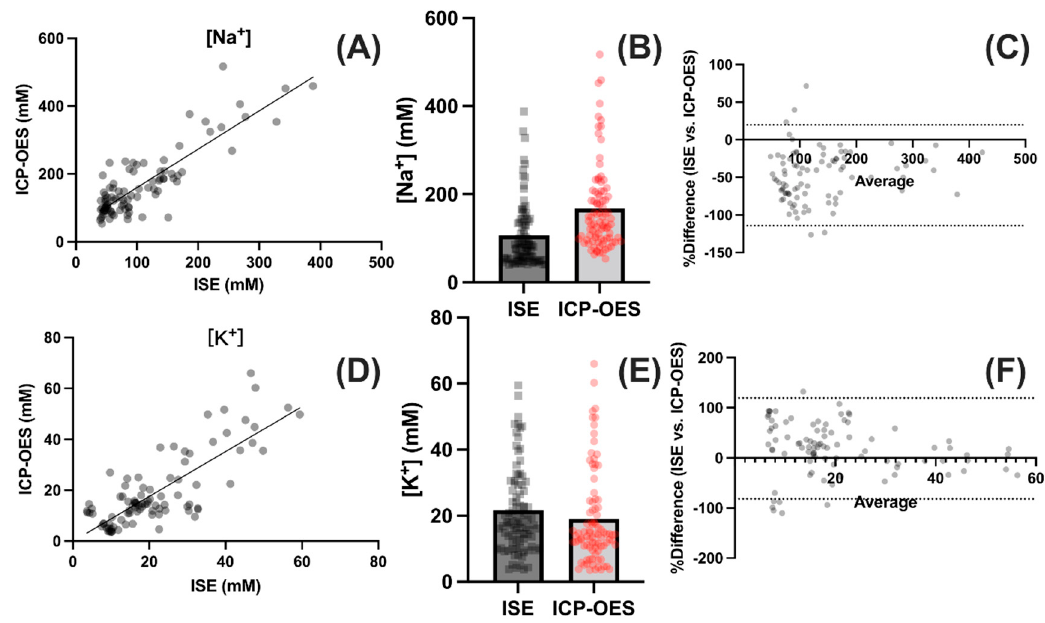
Figure 1. Comparison of sweat sodium ( A – C ) or potassium ( D – F ) ion level measured by ISE and ICP-OES. ( A , D ) Correlation of measured values of the two techniques. ( B , E ) Point plot of all the 90 independent measurements. ( C , F ) Bland Altman comparison plot of percentage of difference vs. average.